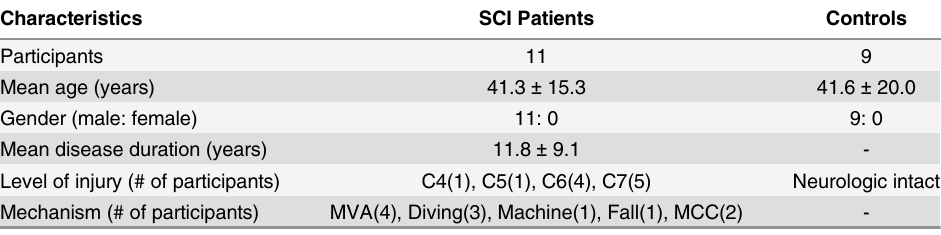
Table 1. Demographic and clinical characteristics of study